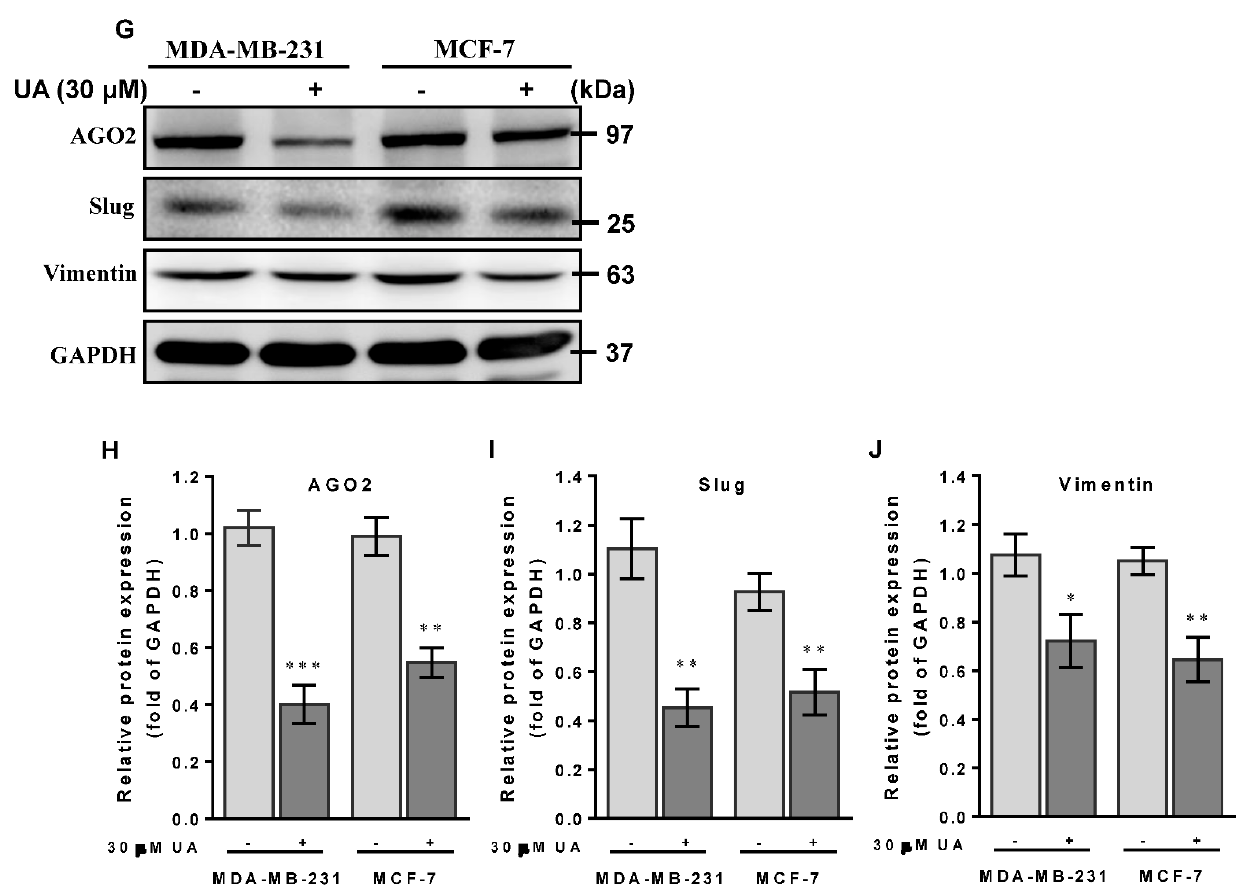
Figure 3. UA suppresses breast cancer cell migration and invasion: ( A ) Effects of UA on inhibition of cancer cell migration (top panel) and invasion (lower panel) for MDA-MB-231 and MCF-7 cells that were analyzed by the Transwell assay; scale bar = 50 µ m. Quantification of migrated cells in ( B ) and invaded cells in ( C ) was presented as mean ± SD of three independent experiments. ** p < 0.01; *** p < 0.001 vs. untreated control. ( D ) Reduction in the AGO2 gene and EMT-related miRNA in ( E ) miR - 9 and ( F ) miR - 221 in breast cancer cell lines treated with UA compared with the control. Relative expression of miRNAs is quantified using TaqMan-based real-time PCR along with RNU6B . ( G ) Representative images of Western blot of mesenchymal proteins and densitometric analyzes of AGO2 in ( H ), slug in ( I ), and vimentin in ( J ) were performed using Digital Protein DNA Imagineware. GAPDH was used as an internal control. All experiments were carried out in triplicate and all data are expressed as mean ± SD. * p < 0.05; ** p < 0.01; *** p < 0.001 vs. the untreated control group.